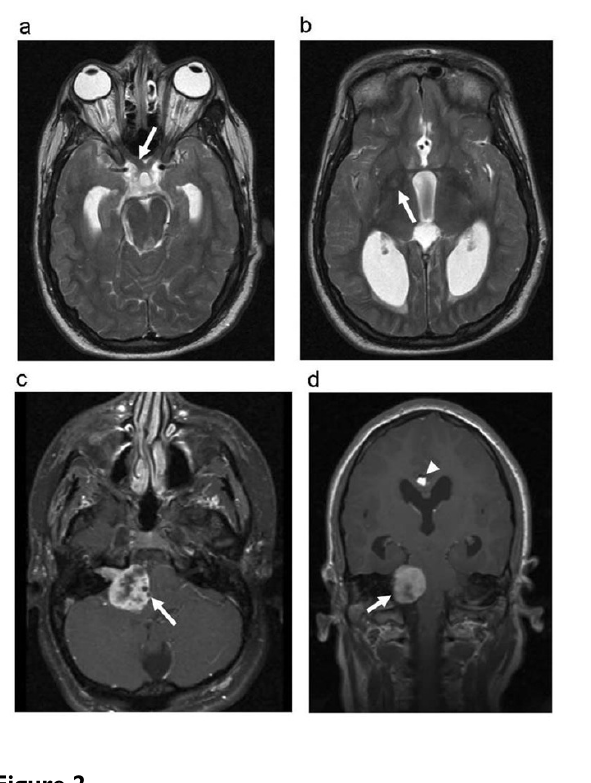
Figure 2 MRI images of the brain at the age of 20 years . (a) Horizontal T2 weighted section showing mild enlargement of the right optic nerve (white arrow) (b) Horizontal T2- weighted image showing a small hyper-intense spot in the right globus pallidus (arrow). Note also hydrocephalus. (c-d) Horizontal and coronal T1 weighted images showing the large partly cystic contrast enhancing schwannoma in the right cerebello-pontine angle. The tumoural mass causes deviation of the brain stem and the cerebellum to the left. (arrow) Note also supratentorial hydrocephalus and an inter- hemispheric lipoma (arrowhead).